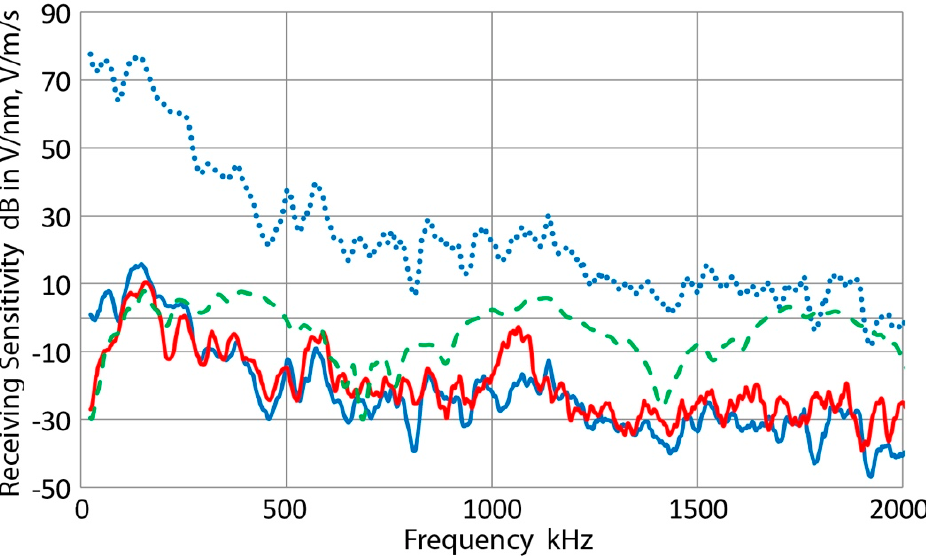
Figure 18. Receiving sensitivity of PAC R15 (BS90). The displacement receiving sensitivities to bar waves are shown in solid blue curve for the present work and in red curve from the old data [8]. (reproduced with permission from [8]. Copyright AE Group, 2010). Green curve is the displacement receiving sensitivity to normally incident waves [4]. The velocity sensitivity corresponding to the solid blue curve is given in dotted blue curve.